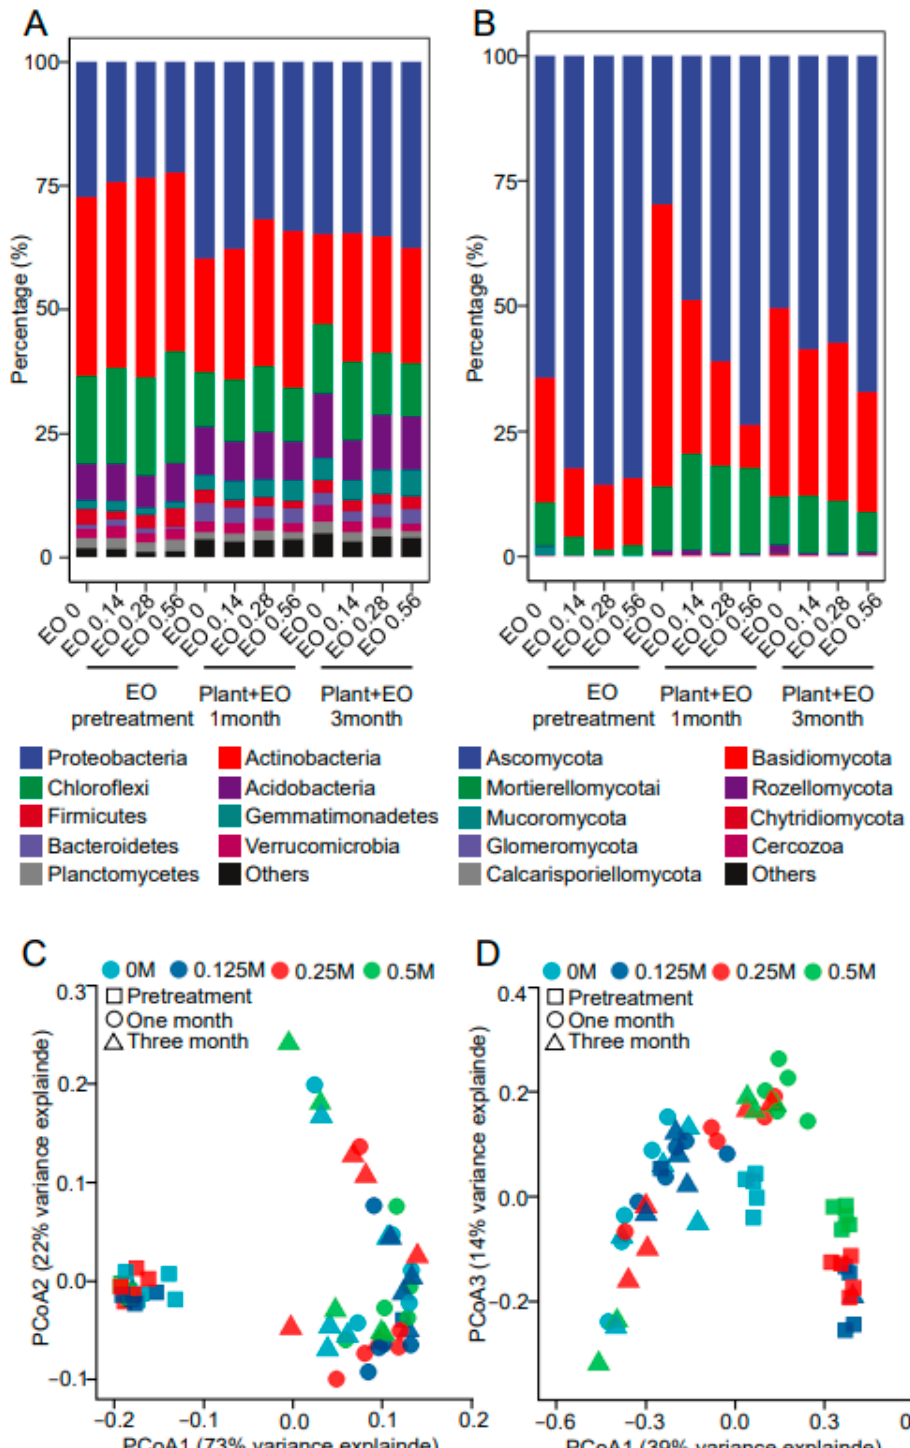
Figure 3. Bacterial ( A ) and fungal ( B ) community composition of the rhizosphere soil samples at the phylum level. Principal coordinate analysis (PCoA) of the microorganism communities in the 16S ( C ) and ITS ( D ) samples. PCoA and dissimilarity distance were based on the Bray–Curtis distance at the OTU level. The concentrations of EO in the soil were 0 mg/g (control), 0.14 mg/g (low concentration), 0.28 mg/g (medium concentration), and 0.56 mg/g (high concentration). The three stages were: EO pretreatment for seven days, then, P. notoginseng was planted and samples were assessed at one and three months.